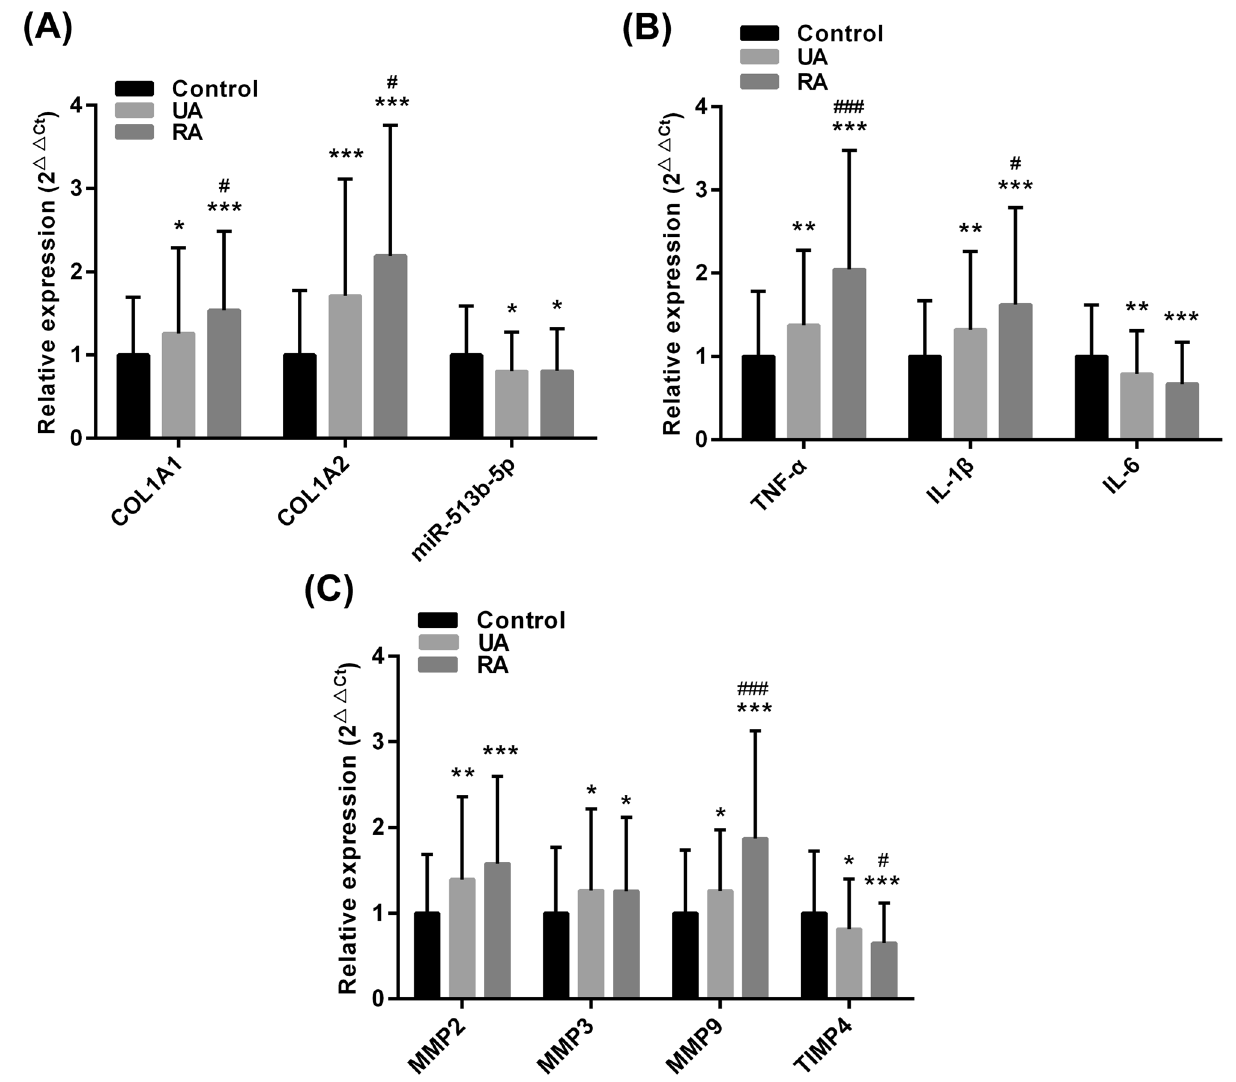
Figure 1. Serum miR-513b-5p and related gene expression in participants. Quantitative RT-PCR assay was used to detected gene expression. ( A ) miR-513b-5p, COL1A1 and COL1A2 expression. ( B ) Inflammatory cytokine of TNF-α, IL-1β and IL-6 mRNA expression. ( C ) MMP2, MMP3, MMP9 and TIMP4 mRNA expression. UA, unrupture aneurysm (n = 100); RA, rupture aneurysm (n = 100); control (n = 100). MiR-513b-5p expression was normalized to cel-miR-39, other mRNA expression was normalized to GAPDH. All of the data are presented as the mean ± standard deviation. Compared with control group, * p < 0.05; ** p < 0.01 and *** p < 0.001. Compared with UA group, # p < 0.05 and ### p < 0.001. Mann–Whitney U test with two-sided was